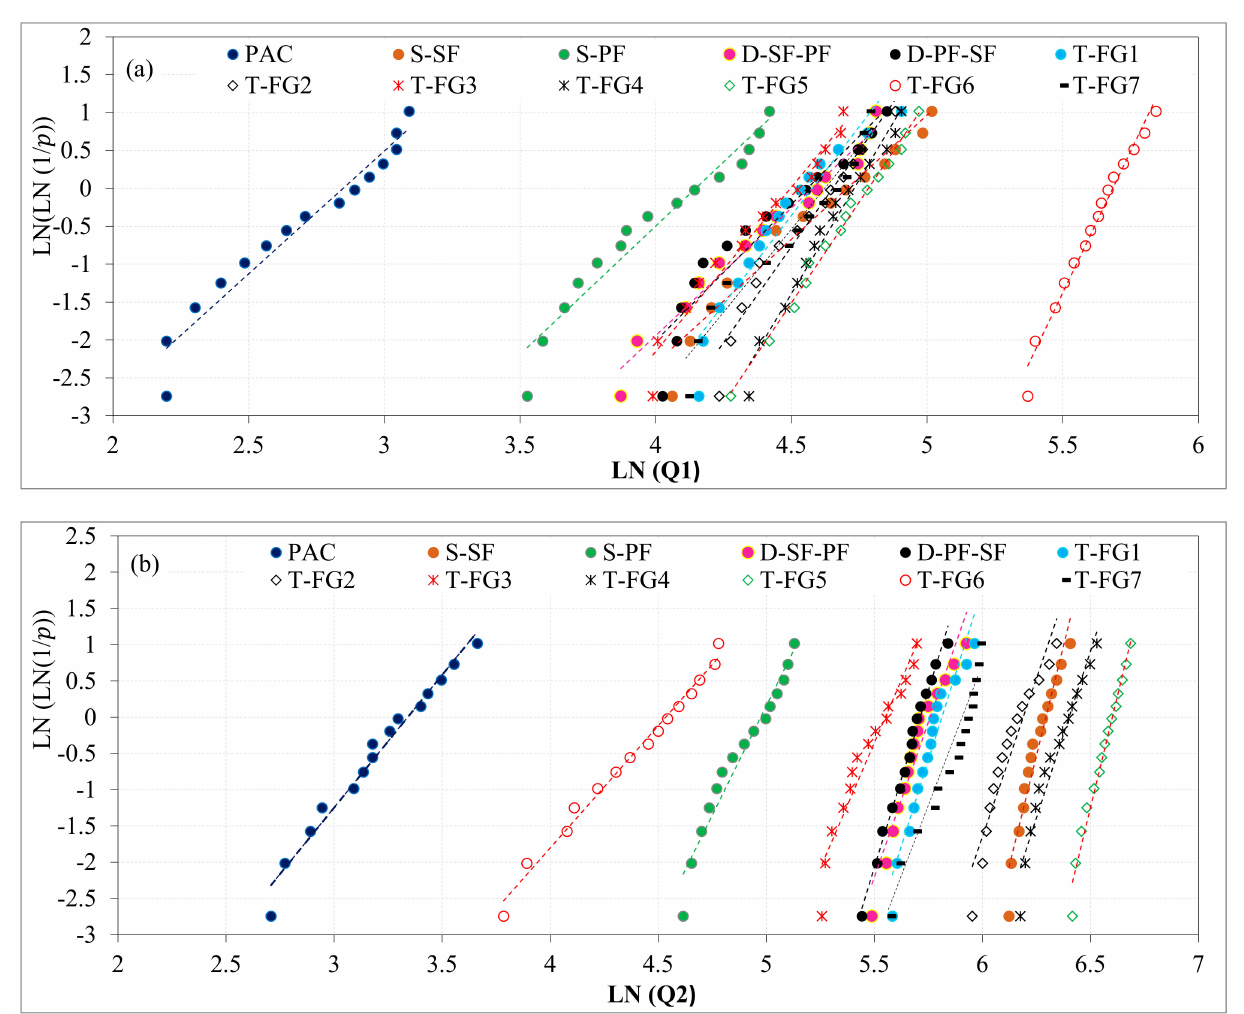
Figure 19. Weibull lines ( a ) Q1, ( b )